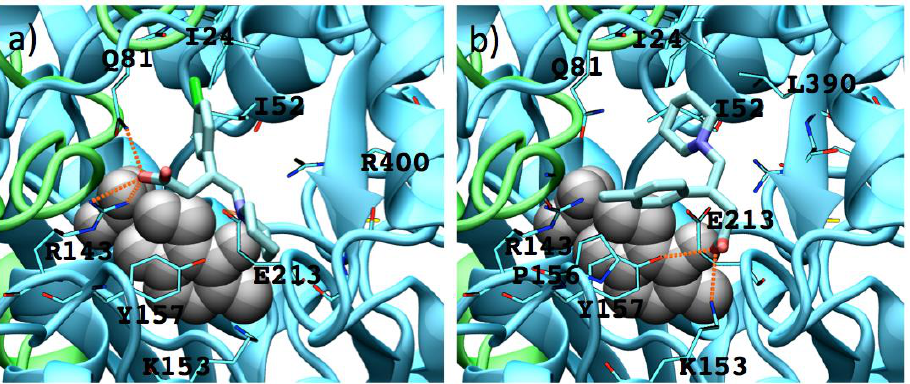
Figure 11. Interactions between 9b enantiomers with P. fluorescens GABA-AT. ( a ) ( S )- 9b and ( b ) ( R )- 9b . PLP prosthetic group is showed as Van der Waals spheres and each protein chain is colored in green and cyan. Residues at 4 Å of each analogue are indicated. Hydrogen bonds are showed as orange dashed lines.